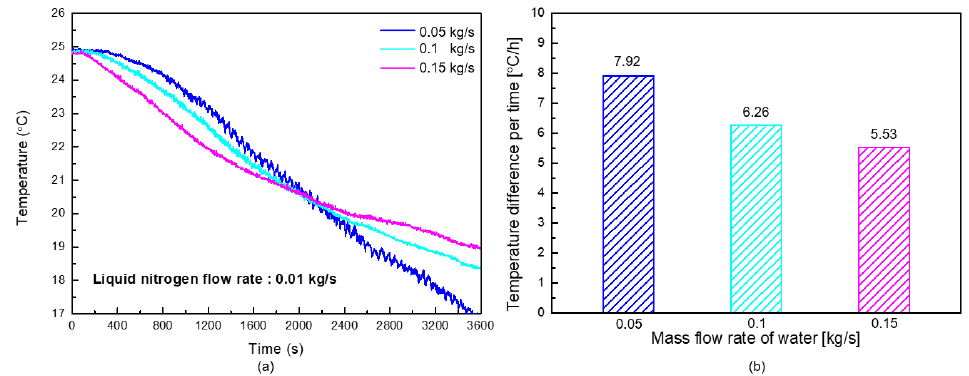
Figure 7. Results of water temperatures ( a ) and water cooling performance in the farming tank at different water mass flow rates ( b ).